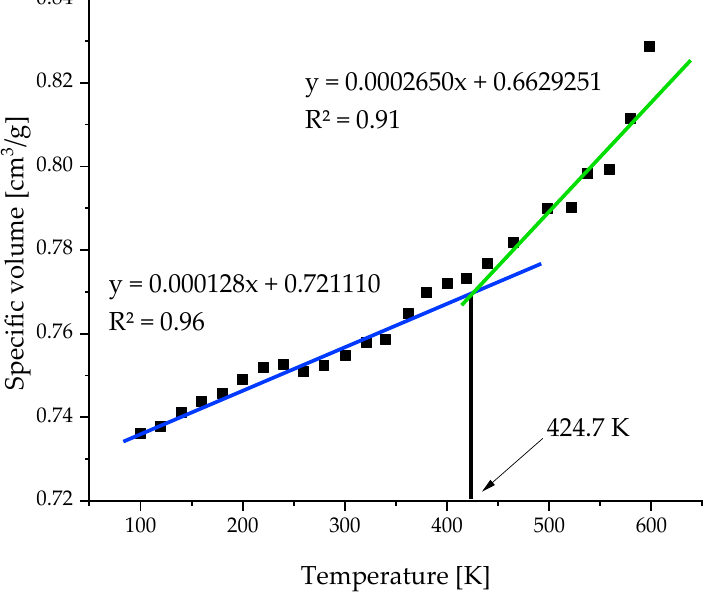
Figure 4. Temperature dependence of specific volume. At 424.7 K there is clear change of curvature of the dependency indicating glass-rubber transition.